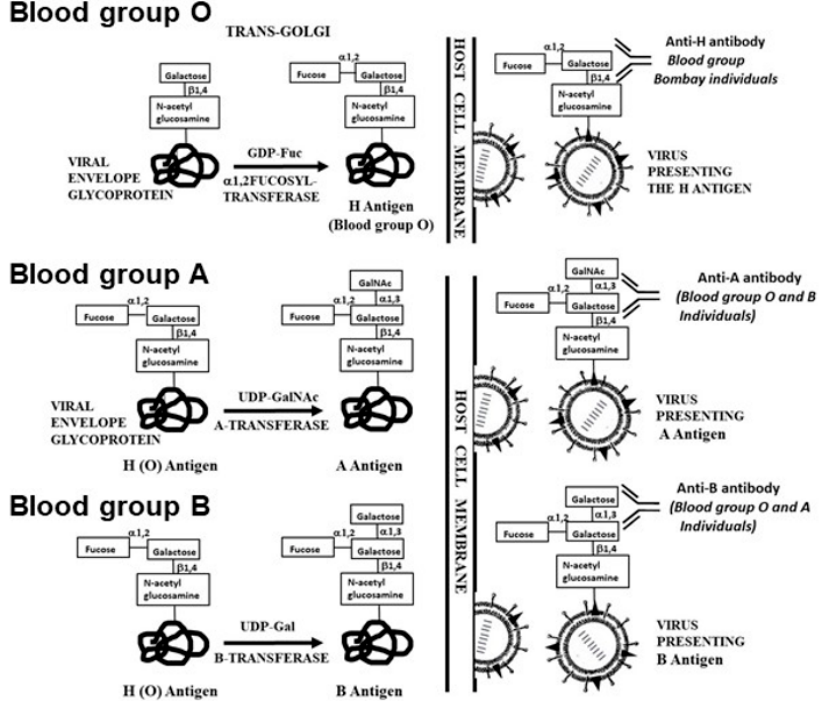
Figure 5. Synthesis of H (O), A and B antigens on the glycan shield of enveloped virus glycoproteins as a result of replication in human host-cells of various blood groups. The corresponding antibodies are according to the blood group. Blood group Bombay individuals have mutations that inactivate the two α 1,2FT genes FUT1 and FUT2 , therefore they cannot synthesize the H antigen (blood group O) and they produce natural anti-H (anti-O) antibody in addition to the production of anti-A and anti-B antibodies. Blood group A and B antigens are synthesized on the H antigen by the corresponding A and B transferases. The synthesized carbohydrate antigens are presented on the glycan shield of the budding virus and bind natural antibodies, as indicated. Modified from ref. [16].